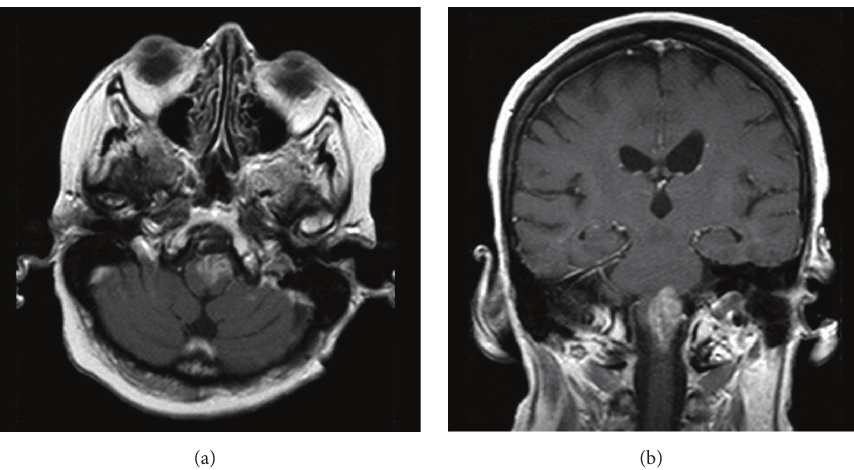
Figure 4: Brain MRI 10 months after surgery. (a) Axial T1-weighted image with gadolinium, showing progression of the enhancing left medullary lesion. (b) Coronal T1-weighted image with gadolinium showing the same medullary lesion.